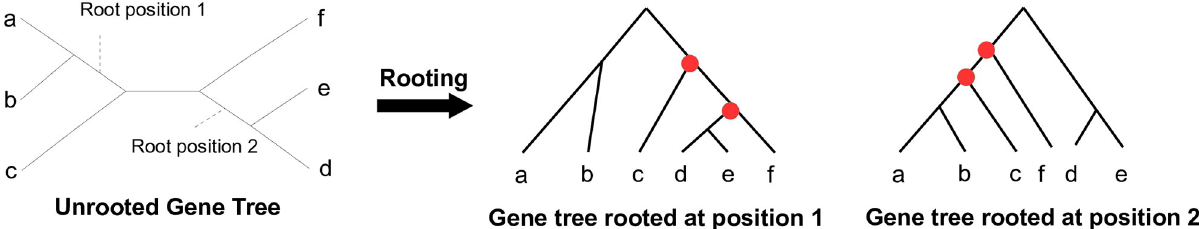
Fig 1. Relationship between alternative rootings and RF distance. The two rooted gene trees, shown on the right, are obtained by rooting the unrooted gene tree on the left along its two marked edges. The shaded (red) nodes on these two rooted trees mark those clades that appear only in one of the rooted trees and not in the other. Thus, the RF distance between these two rooted trees is 2, corresponding to the distance (number of nodes) between the two marked root positions on the unrooted tree.